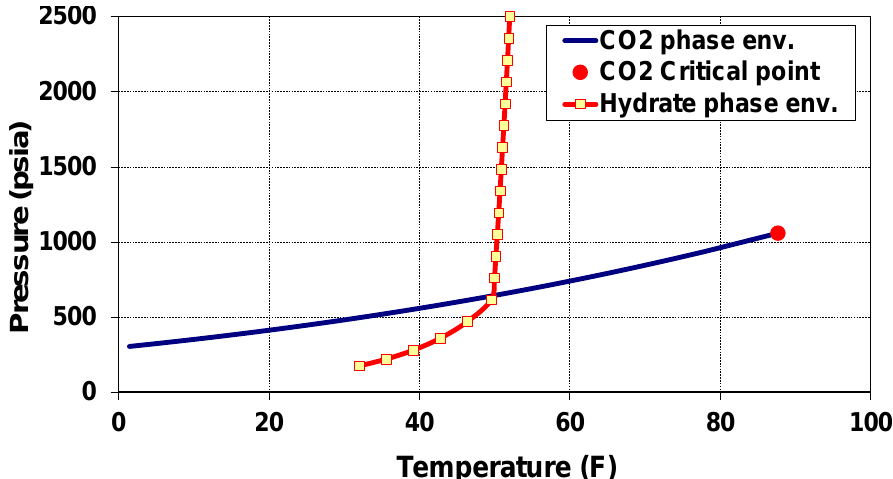
Figure 4. CO 2 hydrate phase envelope and CO 2 PT phase diagram shown versus pressure and temperature. If water and CO 2 are present within the PT region on the left side of the hydrate phase envelope, then CO 2 hydrates will